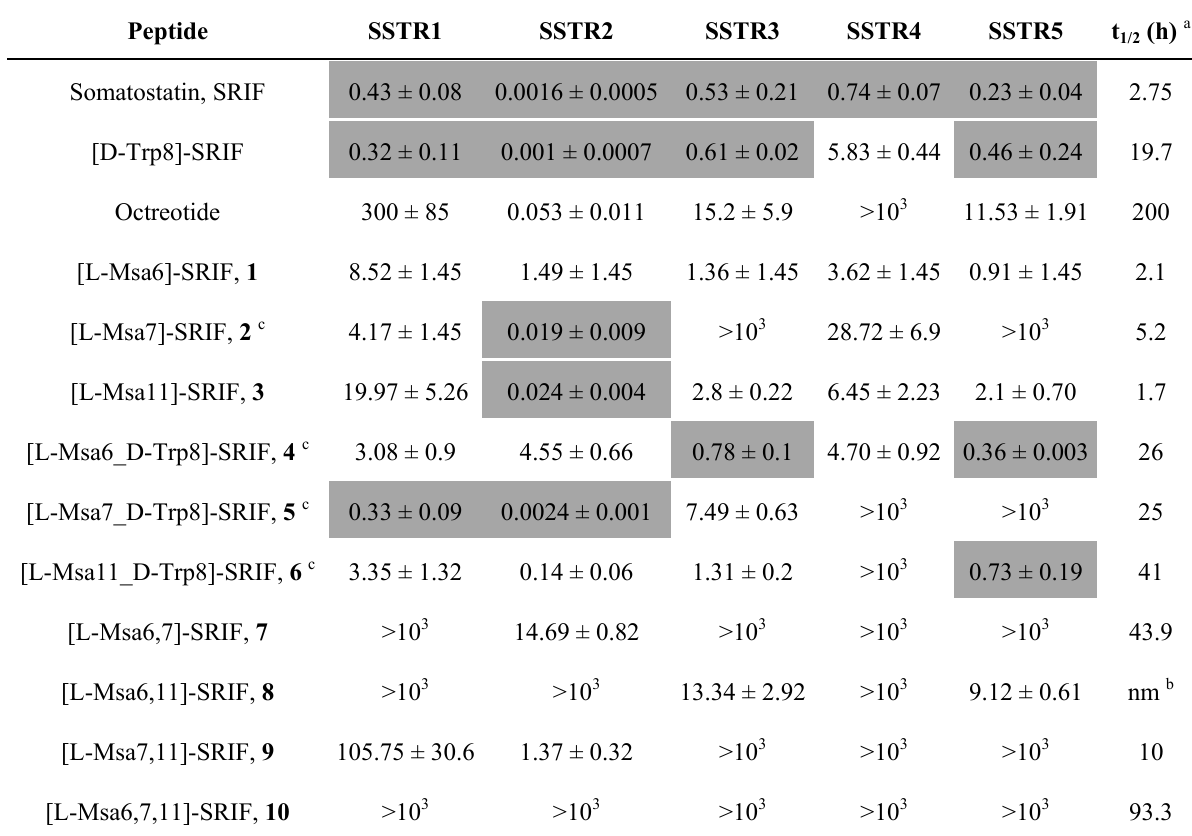
K values are mean ± SEM. Shaded cells represent data in close proximity to the SRIF values. a Human serum i half-life. b Not measured. c Described in the preliminary communication